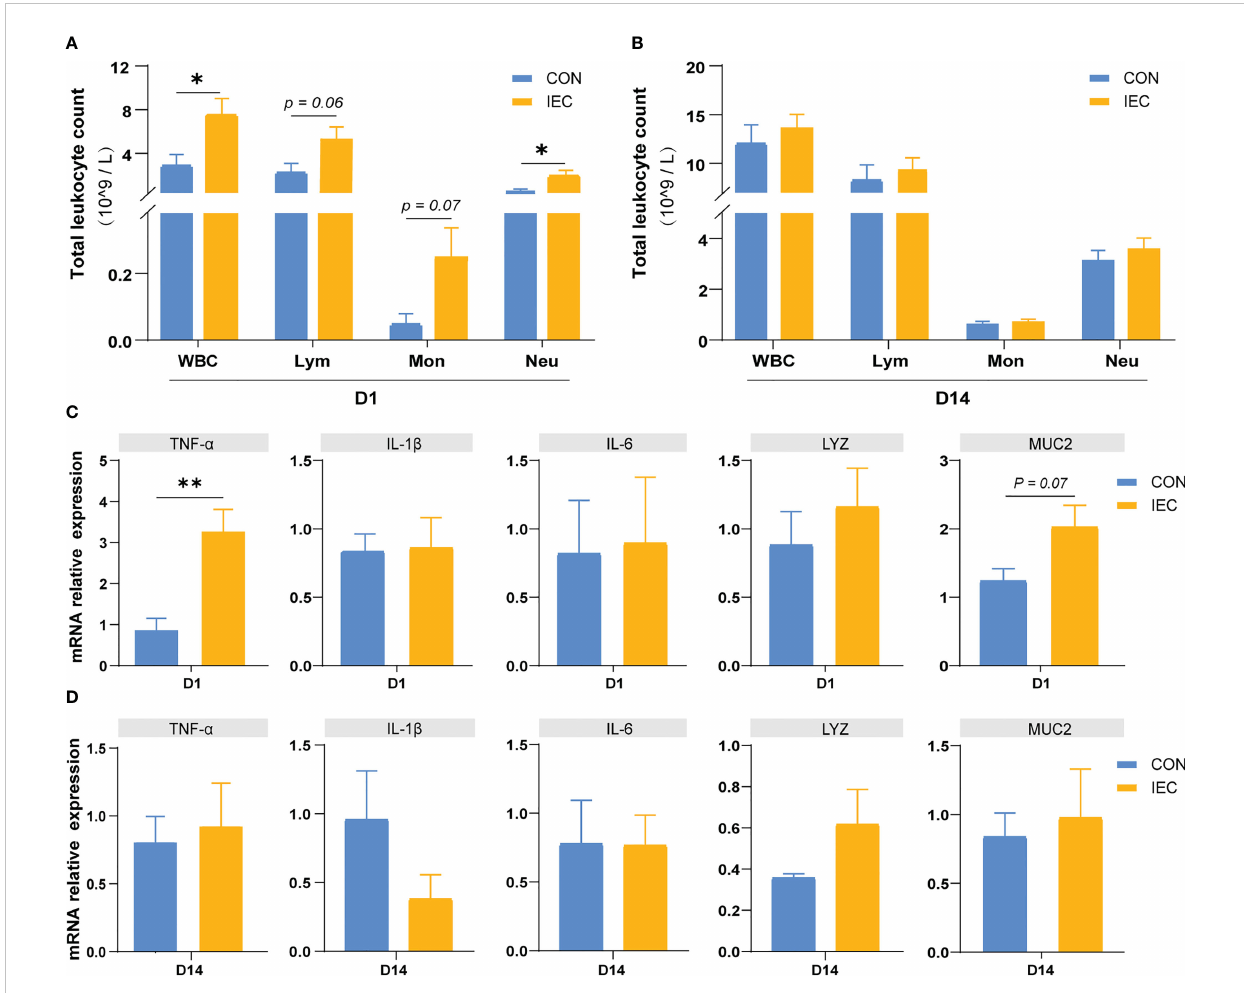
FIGURE 5 Oral administration with IEC induced immune memory. (A, C) Leukocytic index and gene expressions of ileum of rats on D1 (n =4/group). (B, D) Leukocytic index and gene expressions of ileum of rats on D14 (n =4/group). The data are presented as mean ± SEM. Asterisks indicate signi fi cant difference between the IEC group and the CON group (* P < 0.05; ** P < 0.01). WBC, white blood cell; Lym, lymphocyte; Mon, monocyte; Neu, neutrophilicgranulocyte; TNF-a , Tumor necrosis factor-a; IL , Interleukin; LYZ , Lysozyme; MUC ,